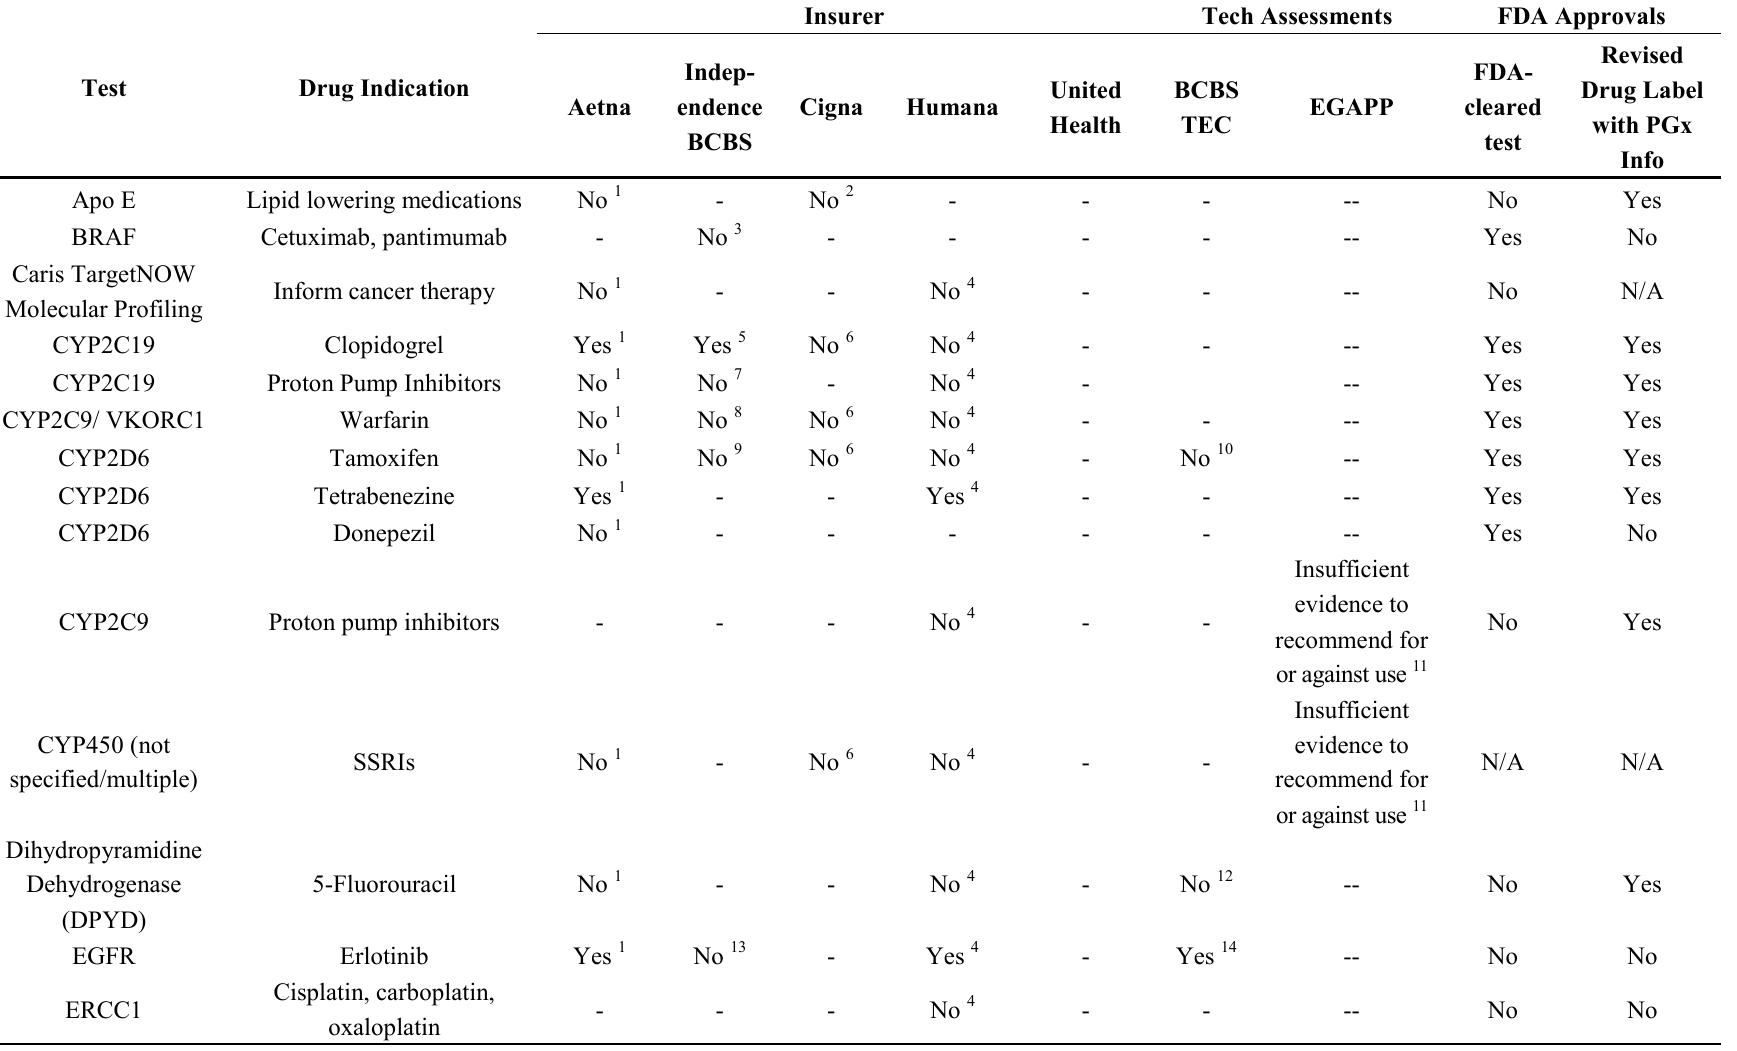
Table 3. Coverage Policies for Pharmacogenetic Tests by Insurer (policies were identified in August 2012 as described in the Methods